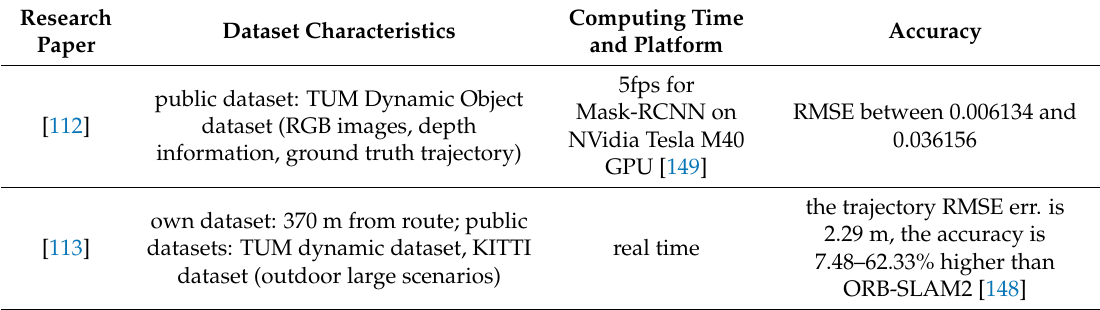
Table 15. Characteristics of indoor localization solutions with an existing/generated 3D model of the environment, 2D mobile cameras, real features, and artificial